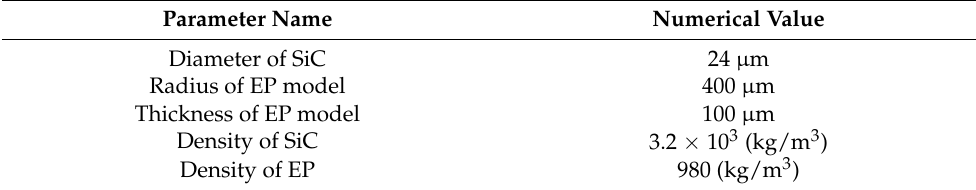
Table 3. Geometric parameter setting of micron composite model.